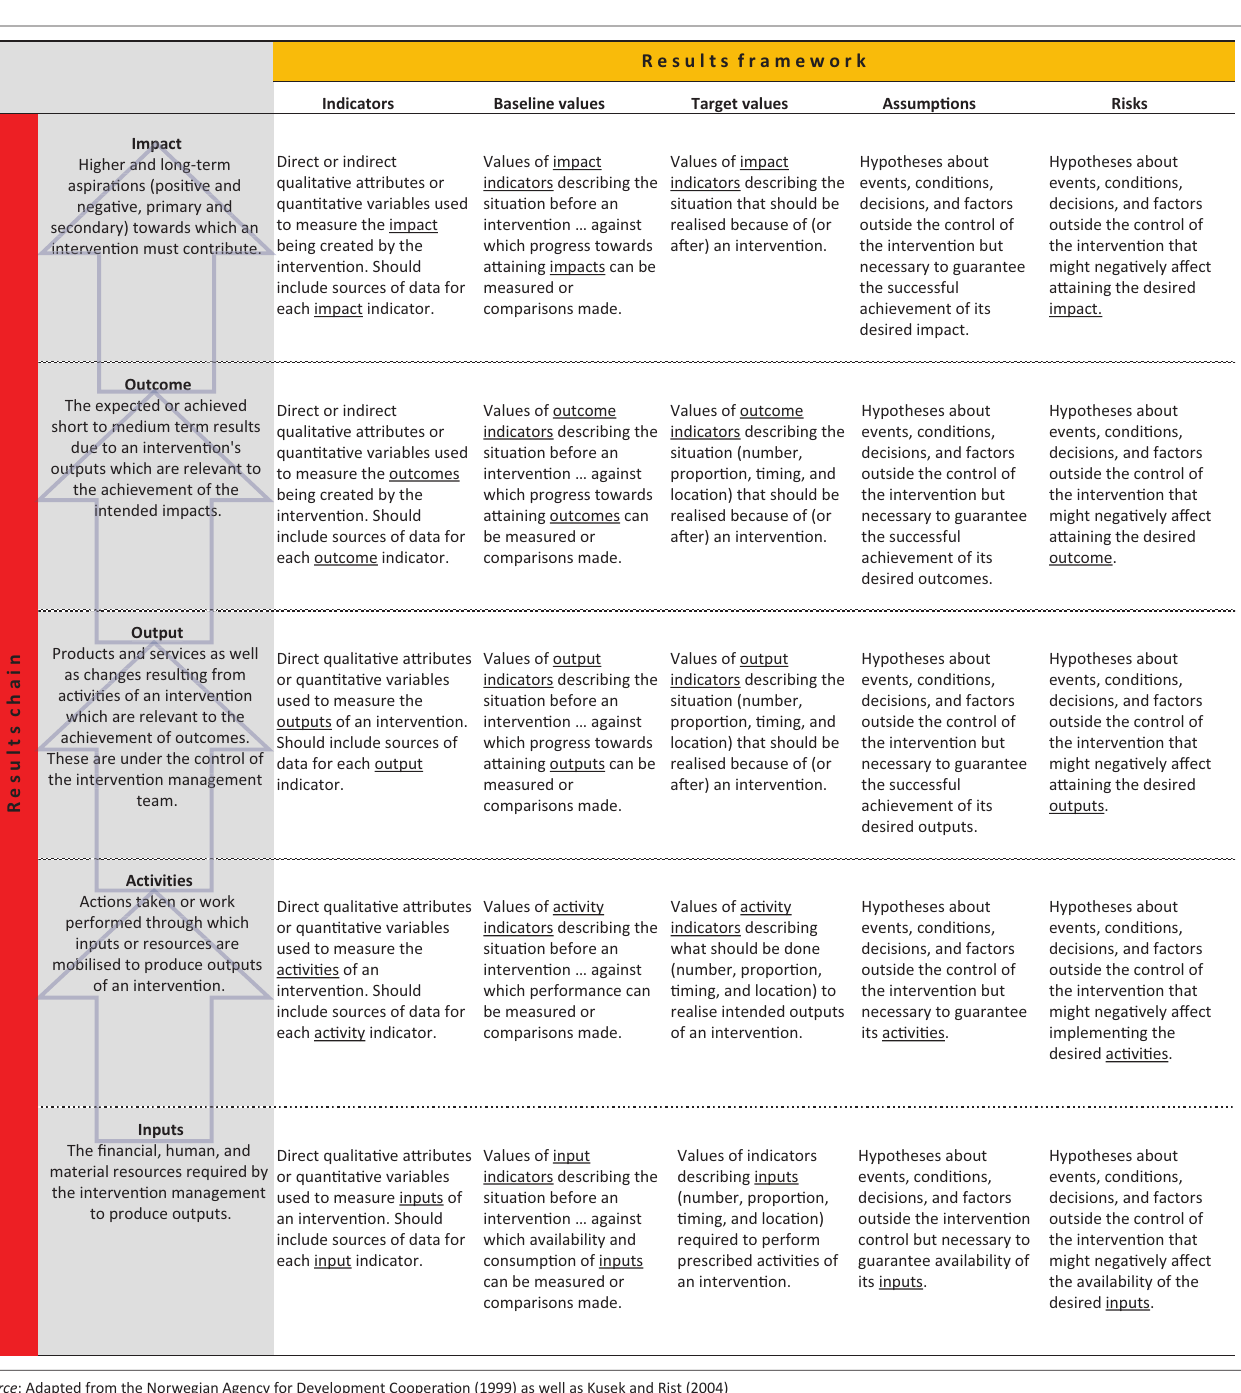
managerialist approach. The former is ‘rule-bound and hierarchical, built around centralised power and authority’ with pre-programmed standardised procedures emphasising compliance rather than results (Dixon, Kouzmin & Korac- Kakabadse 1998; Paine 1999:49). The latter uses private